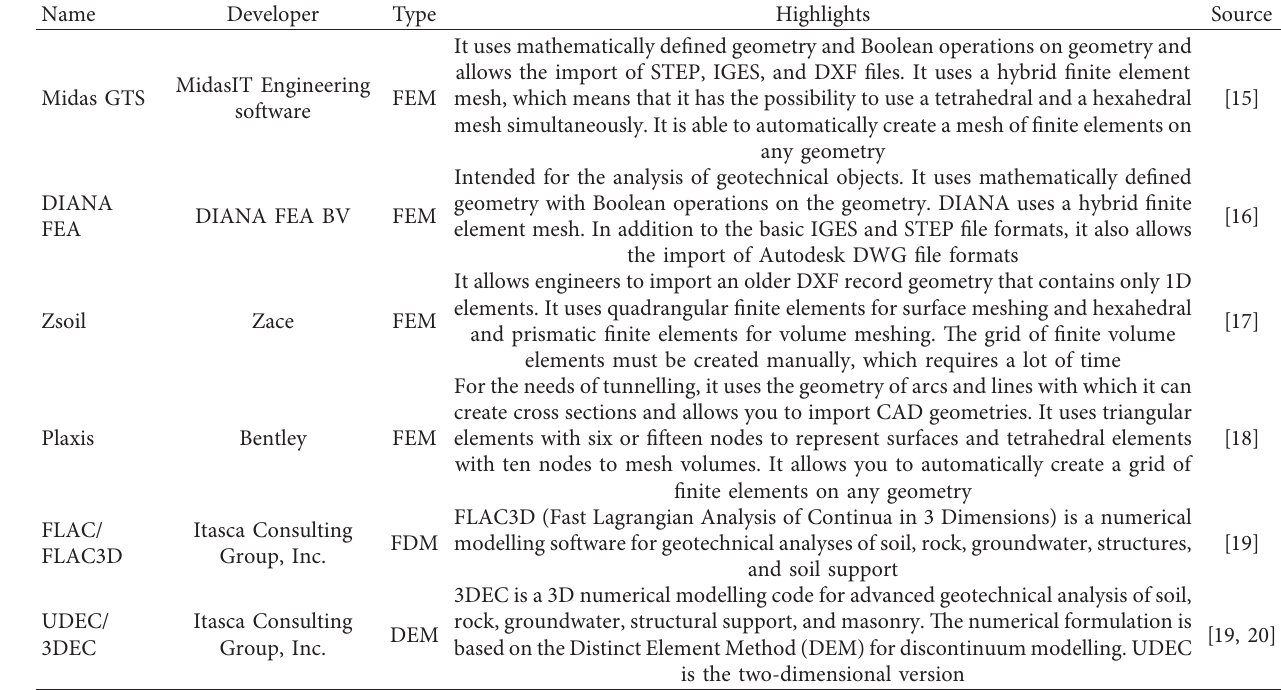
Table 1: List of software packages mostly used for geotechnical